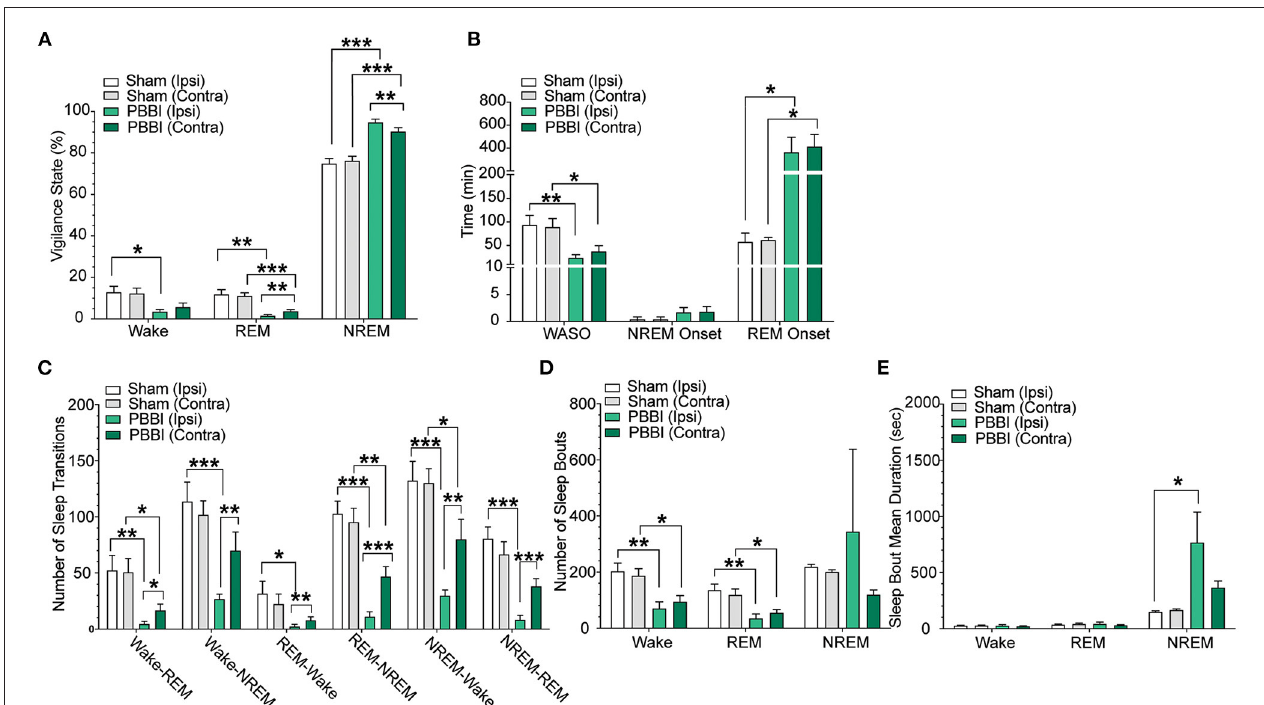
FIGURE 4 | Sleep parameters for contralateral and ipsilateral hemispheres in sham and PBBI animals in the light phase during the acute post-injury period. Time spent in each vigilance state was collapsed over 12h bins and compared between hemispheres and injury groups. (A) PBBI rats showed significant increases in NREM sleep with accompanying decreases in REM sleep, (B) shorter periods of wake after sleep onset (WASO), (C) fewer sleep stage transitions, (D) fewer sleep stage bouts, and (E) increased mean bout duration during NREM sleep (ipsilateral side only). Significant changes were more prevalent on the ipsilateral side. N = 6 PBBI / 5 sham. All data are depicted as the mean ± SEM. WASO: wake after sleep onset (*** p < 0.001, ** p < 0.01, * p <